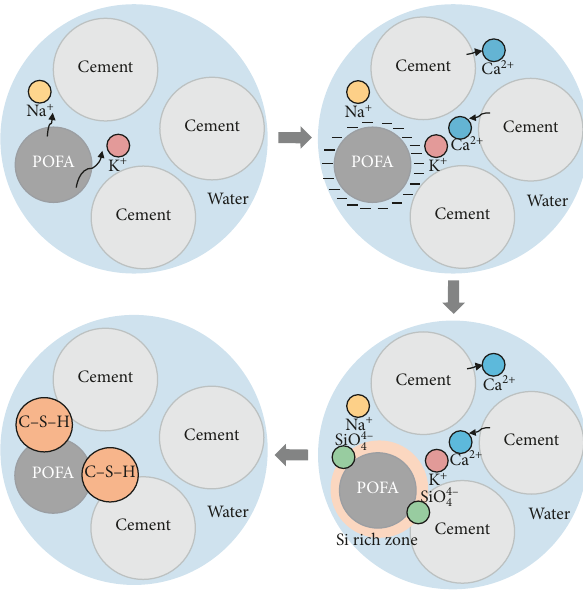
Figure 10: Role of mPOFA in cement